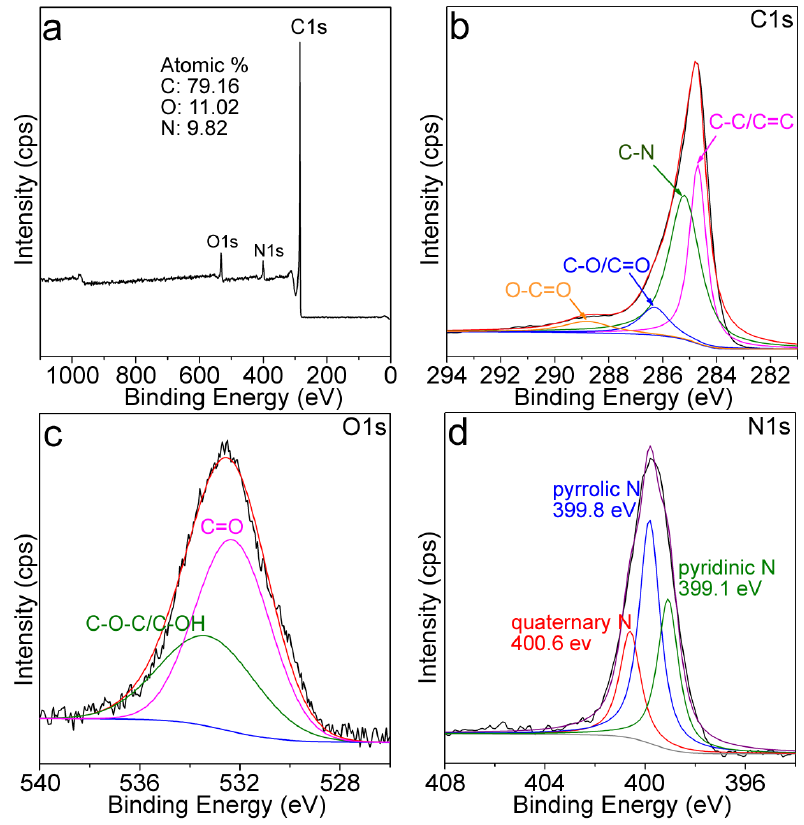
Figure 3. ( a ) X-ray photoelectron spectroscopy (XPS) Full survey; ( b ) C1s, ( c ) O1s, ( d ) N1s of the MPC.